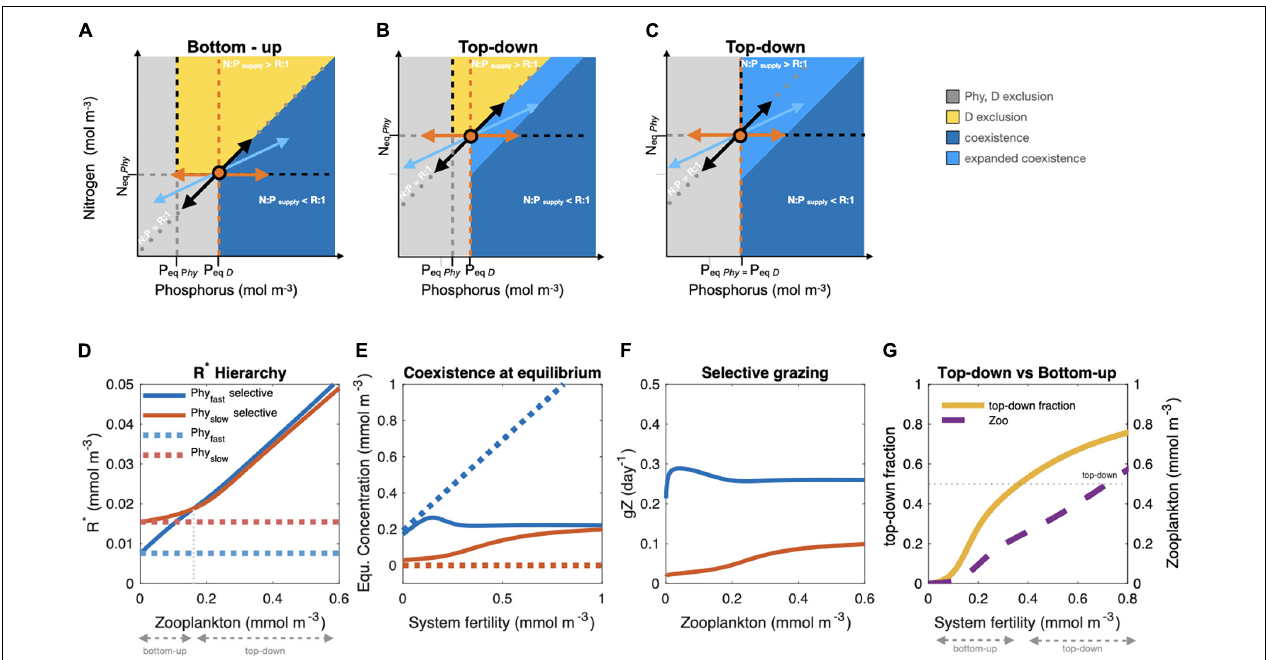
FIGURE 1 | (A) Traditional RCT graphical approach (considering equal mortality and nutrient requirements independent from one another). In an idealized system, phytoplankton ( Phy , black) and diazotrophs ( D , orange) competing for nitrogen, N, and phosphorus, P, draw down nutrient concentrations to their individual equilibrium nutrient requirements (R*), here N eq and P eq , reaching steady state (growth = mortality) on the zero net growth isoclines (ZNGI, black, and orange dashed lines). For nutrient supply below N eq , P eq both algae cannot grow (gray region, mortality > growth). Phy consume nutrients (black arrow pointing toward axis origin) in their cellular proportions of R. D consume P only (orange arrow pointing left) and supply extra N . At steady state, total N and P consumption (blue vectors pointing toward low N and P ) must be balanced by the nutrient supply (blue vectors pointing toward high N and P). Stable coexistence of Phy and D occurs at the interception of the ZNGIs where the growth of Phy is limited by N and that of D is limited by P . This occurs when N:P supply < R, i.e., when the resource limiting the slower-growing phytoplankton is supplied in excess. Note that the region of coexistence extends all the way to the x axis (0 N supply) because the N added by D can be utilized by Phy . (B) R* depends on physiological characteristics and grazing pressure ( gZ ; Eq. 1). Accounting for selective grazing on Phy ( gZ Phy > gZ D ) can increase the nutrient requirements N eq and P eq of the faster-growing competitor, thereby expanding the region of coexistence. (C) Should P eq Phy = P eq D Phy becomes limited by P also for N:P supply > R, allowing D to coexist in high N supply regions (see Supplementary Material for analytical derivation). (D) R* hierarchy: RCT predicts that in competition for the same resource, the species with the lowest R* (mmol m - 3 ) will dominate. Fast growing species (blue dashed line) dominate slowly growing ones (red dashed line) in the absence of grazing ( gZ = 0 ), or selective grazing ( gZ fast = gZ slow ). The inversion of the R* hierarchy occurs with selective grazing on the fastest growing organism ( gZ fast > gZ slow , solid lines). (E) Coexistence at equilibrium as a function of ecosystem fertility (nutrient initial conditions) for the fast (blue) and slow (red) phytoplankton in the absence of grazing or selective grazing (dashed lines) and with selective grazing ( gZ fast > gZ slow , solid lines). (F) Grazing rates ( g i Z , day - 1 ) on the fast and slow phytoplankton as a function of zooplankton biomass ( Z , mmol m - 3 ). (G) Top-down versus bottom-up control on R* P(cid:16) (cid:17) ∗ as a function of system fertility. Top-down fraction (tdf) calculated as: tdf = 1 − R i n − 1 , where for each i th species R ∗ i min = R ∗ i for g i Z = 0, i.e., for pure min R ∗ i bottom-up control, and n is the number of species. Plots (D–G) are based on equilibrium solutions of a 100-member ensemble of a 0D ecosystem model [nutrients ( N ), fast-growing ( Phy fast ) and slow-growing phytoplankton ( Phy slow ), and zooplankton ( Z )] with different initial nutrient levels. Phy fast and Phy slow differ only in their maximum growth rate ( µ max , 1.3 and 0.65 day − 1 , respectively) and palatability ( ∅ i ,0.7 and 0.3, respectively). All other ecosystem model parameters are equal (half saturation constant for nutrient uptake k = 0.5 mmol m − 3 ; linear mortality m = 0.03 day − 1 ; maximum grazing rate g max = 0 . 4 day − 1 ; and prey half saturation Phy 2 i constant k z = 0.5 mmol m − 3 ). The grazing rate per unit biomass g i (m 3 mmol − 1 day − 1 ) is of the form: g i = g max ∅ i (cid:54) Phyi kz 2 + (cid:54) Phy 2 i i